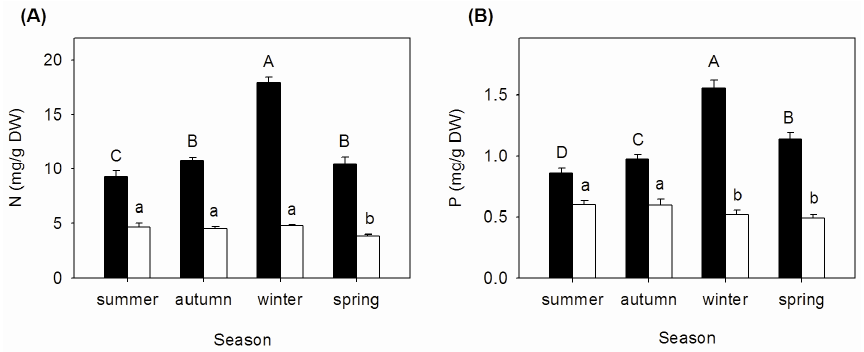
Figure 1. Seasonal changes in the ( A ) nitrogen (N) and ( B ) phosphorus (P) concentrations in leaves of A. corniculatum . Symbols are black bars for mature leaves and white bars for senescent leaves. Different capital letters indicate significant differences among seasons for N and P concentrations in mature leaves at p < 0.05. Different lowercase letters indicate significant differences among seasons for N and P concentrations in senescent leaves at p < 0.05.